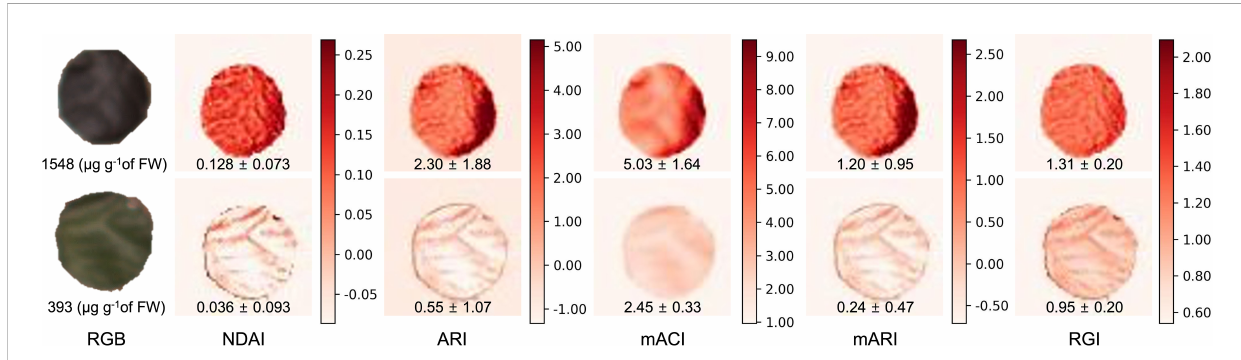
FIGURE 3 Images of various indices of anthocyanin concentration based on multispectral images. The leaf disc at the top had a higher anthocyanin concentration than the bottom one. From left to right: RGB (color) image, normalized difference anthocyanin index (NDAI; Eq. 1), anthocyanin re fl ectance index (ARI; Eq. 3), modi fi ed anthocyanin content index (mACI; Eq. 4), modi fi ed anthocyanin re fl ectance index (mARI; Eq. 5), and red to green ratio index (RGI; Eq. 6). The values in each image represents the average ± standard deviation of the corresponding index value, while the RGB images show the anthocyanin concentration of the leaf